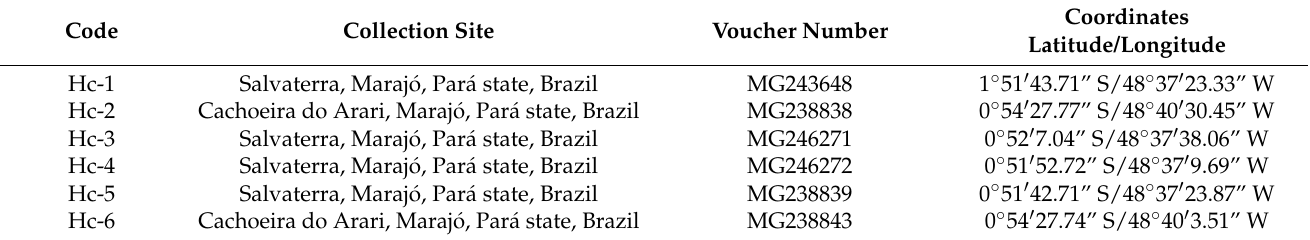
Table 2. Collection site, herbarium voucher number, and geographic coordinates for the Hyptis crenata